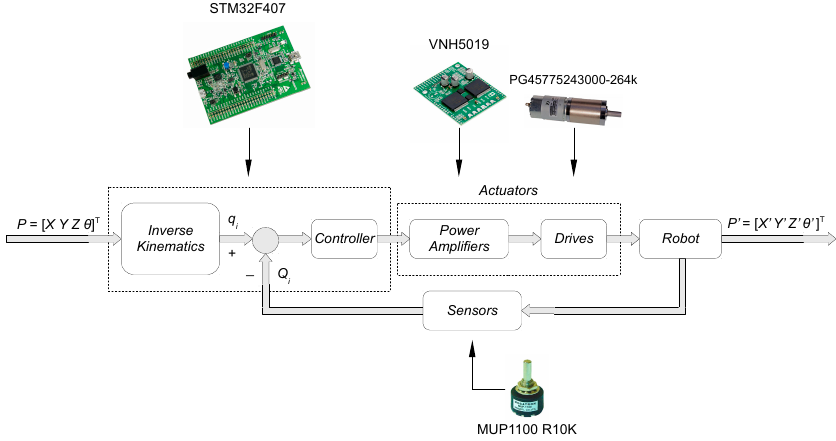
Figure 10. A control diagram of the control system of the designed robot (in the connector space). The measuring element converts the measured physical quantity into voltage which is converted to the adjustable volume Q i (the angular position of a single arm is measured) through the ADC transmitter of STM32F4 system and appropriate scaling. Subsequently, this quantity is implemented directly to the input of the controller through the accumulated node (differential